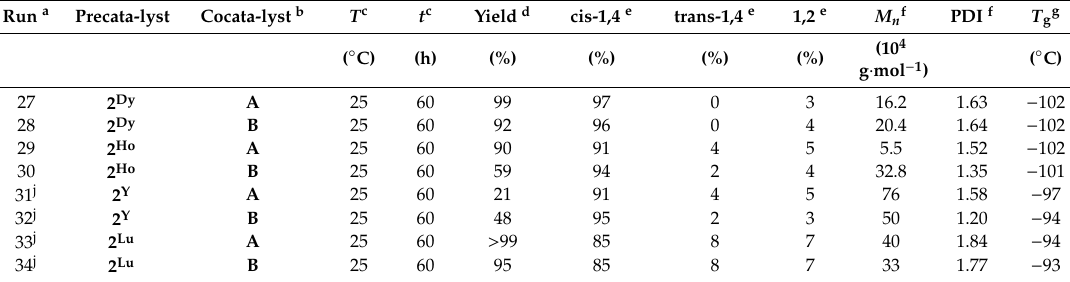
Table 4. 1,3-Butadiene homopolymerization by [Cp*LnMe 2 ] 3 ( 2 Ln